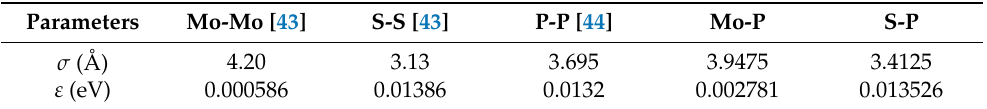
Table 2. The LJ parameters of BP and MoS